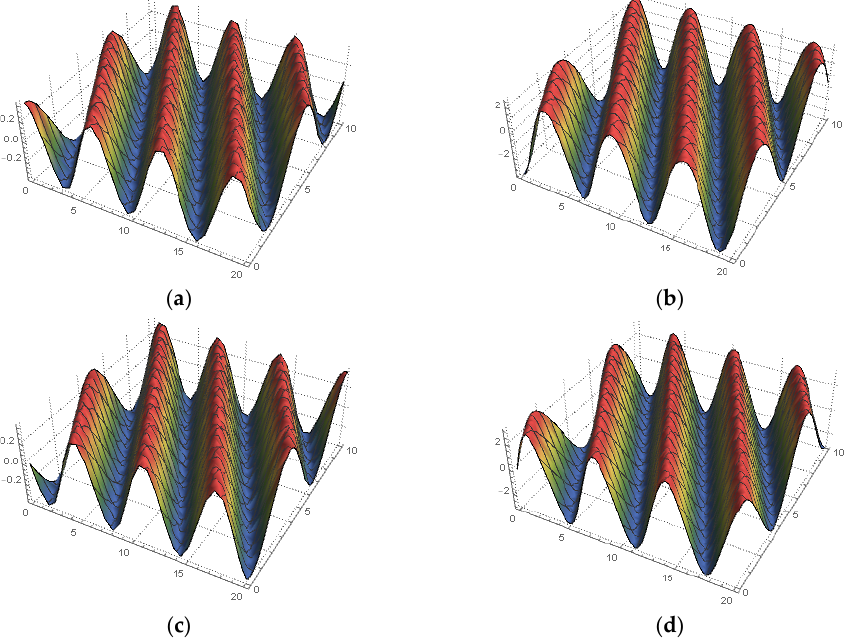
and with the parameters Figure 4. The 3D plots of the real and imaginary parts of Figure 4. The 3D plots of the real and imaginary parts of F 6 ( x , t ) and G 6 ( x , t ) with the parameters and for the fractional order r 1 = r 2 = − 1, k 1 = k 2 = 1, q 0 = − 2.5, p 3 = 0, q 1 = − 1, ρ = 1 and τ = 0 for the fractional order 𝐹𝐹 6 ( 𝑥𝑥 , 𝑑𝑑 ) 𝐺𝐺 6 ( 𝑥𝑥 , 𝑑𝑑 ) , ( b ) ( c ) and ( d ) 𝑟𝑟 1 = 𝑟𝑟 2 = − 1, 𝑘𝑘 1 = 𝑘𝑘 2 = 1, 𝑞𝑞 0 = − 2.5, 𝑝𝑝 3 = 0, 𝑞𝑞 1 = − 1, 𝜌𝜌 = 1 𝜏𝜏 = 0 𝛼𝛼 = α = 1: ( a ) Re [ F 6 ( x , t )] , ( b ) Re [ G 6 ( x , t )] , ( c ) Im [ F 6 ( x , t )] and ( d ) Im [ G 6 ( x , t )] 𝑅𝑅𝑒𝑒 [ 𝐹𝐹 6 ( 𝑥𝑥 , 𝑑𝑑 )] 𝑅𝑅𝑒𝑒 [ 𝐺𝐺 6 ( 𝑥𝑥 , 𝑑𝑑 )], 𝐼𝐼𝐼𝐼 [ 𝐹𝐹 6 ( 𝑥𝑥 , 𝑑𝑑 )] 𝐼𝐼𝐼𝐼 [ 𝐺𝐺 6 ( 𝑥𝑥 , 𝑑𝑑 )].